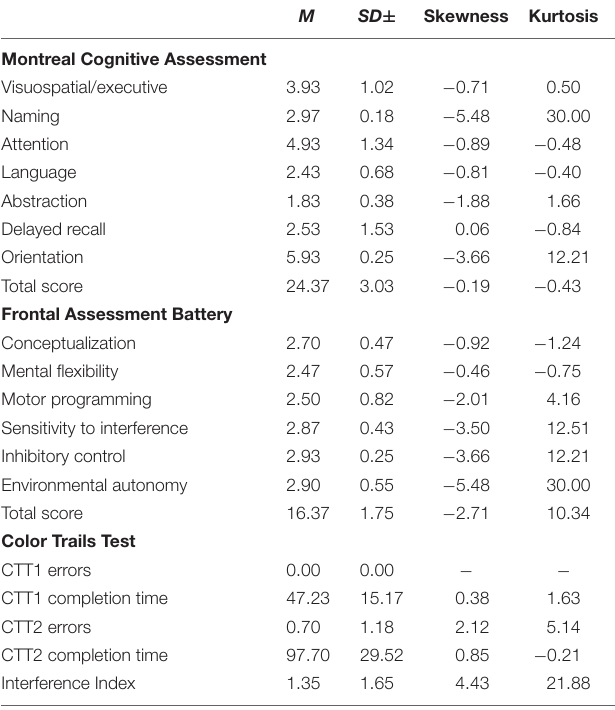
TABLE 1 | Descriptive analyses of the neuropsychological outcomes.